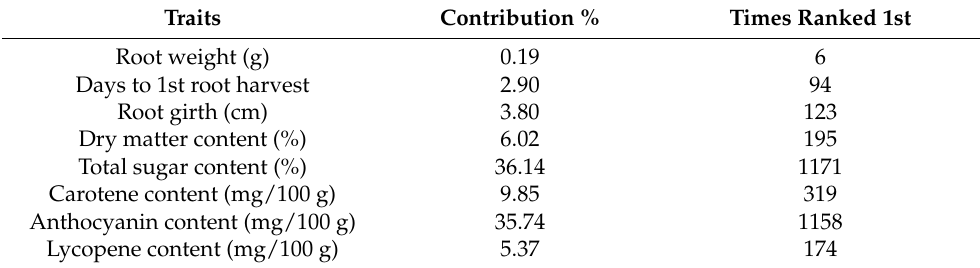
Table 5. Percent contribution of different traits to genetic divergence.